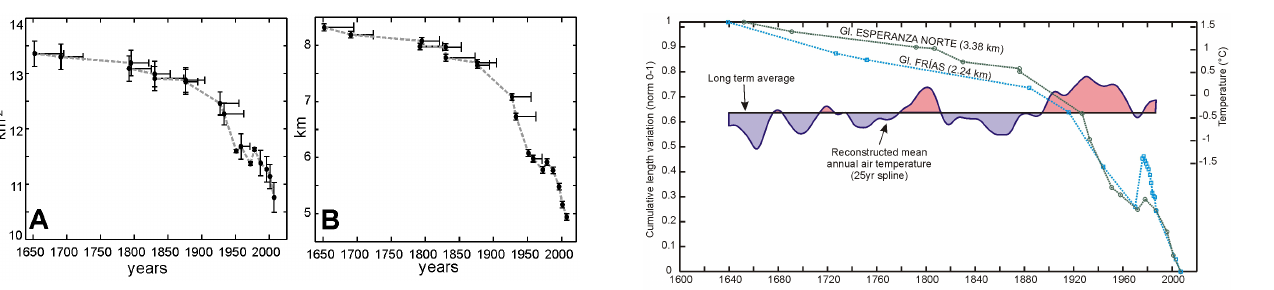
Fig. 7. Comparison of the frontal variations of Glaciar Esperanza Norte (green dashed line) and Glaciar Fr´ıas (blue dashed line) be- tween their LIA peak extent and 2007. Both records have been normalized to facilitate the comparison, with the total cumulative length reduction indicated in parentheses in each case. The interpo- lation lines connecting dates of glacier position are drawn to facil- itate the analysis but do not suggest linear trends between adjacent data points. However, note the similarity in the general shape of these curves. Also shown is a smoothed version of a mean annual (April–March) temperature reconstruction developed for northern Patagonia (Villalba et al., 2003). Glacier variations during the past four centuries seem consistent with the temperature reconstruction showing cold conditions from 1640AD to 1850, followed by a warming trend from the 1850s to 1930s, a period of moderate cool- ing from the 1940s to mid 1970s, and a return to warmer conditions in the last